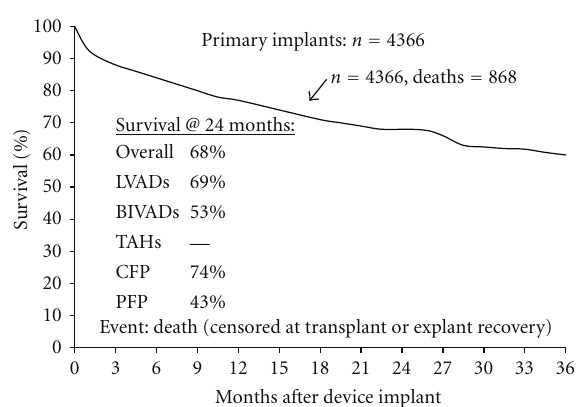
Figure 1: Actuarial survival (censored at transplant or explant/ recovery) among 4,366 ventricular assist device implants from 06/23, 2006-06/30, 2011 and additionally stratified by device type, and pump type. ( with permission from: The Fourth INTERMACS Annual Report) [32]. Abbreviations: INTERMACS: Interagency Registry for Mechanically Assisted Circulatory Support. LVAD: left ventricular assist device. BiVAD: biventricular assist device. TAH: total artificial heart. CFP: continuous-flow pumps. PFP: pulsatile- flow